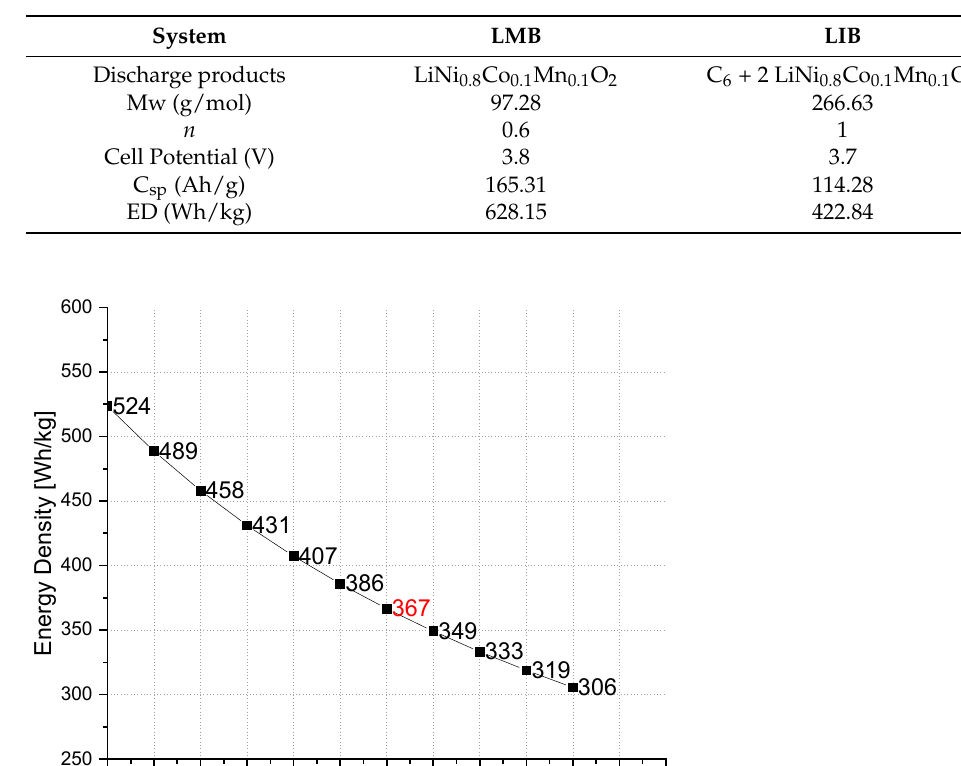
Table 2. Theoretical specific capacities and energy densities calculated for zero-excess LMB and LIB.